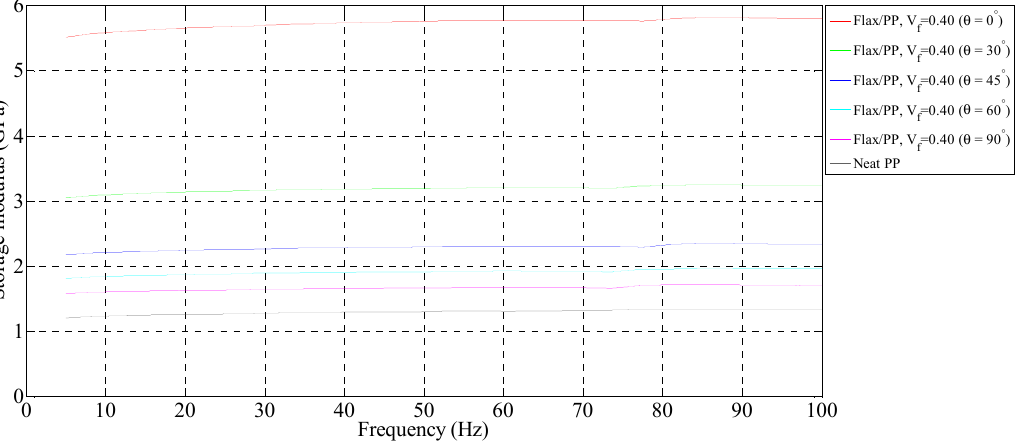
Figure 4. Storage modulus of flax/PP composite samples of different fibre orientations for a fibre volume fraction of 0.40 and a neat PP sample.